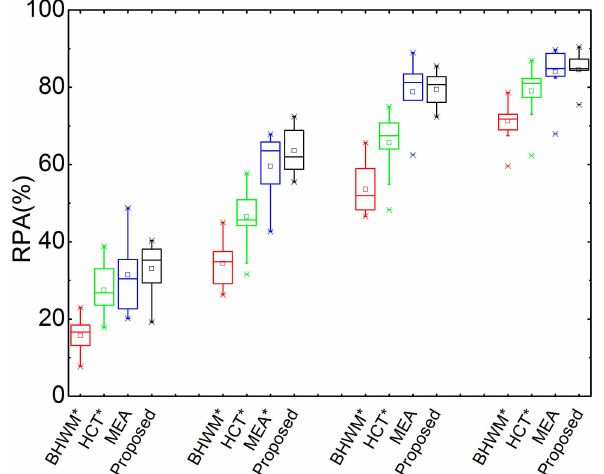
Figure 3. RPAs of compared methods on Bach10 (%). These four groups correspond to different SARs, i.e., − 5 dB, 0 dB, 5 dB, and 10 dB from left to right. The asterisk is to indicate the superiority of the proposed method at this metric and the SAR is significant. This sign is used for the same meaning in the following figures.